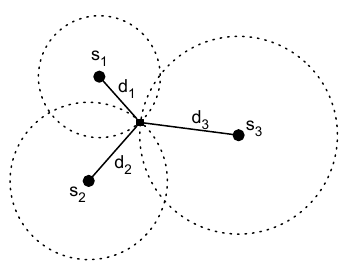
Figure 2. Lateration method